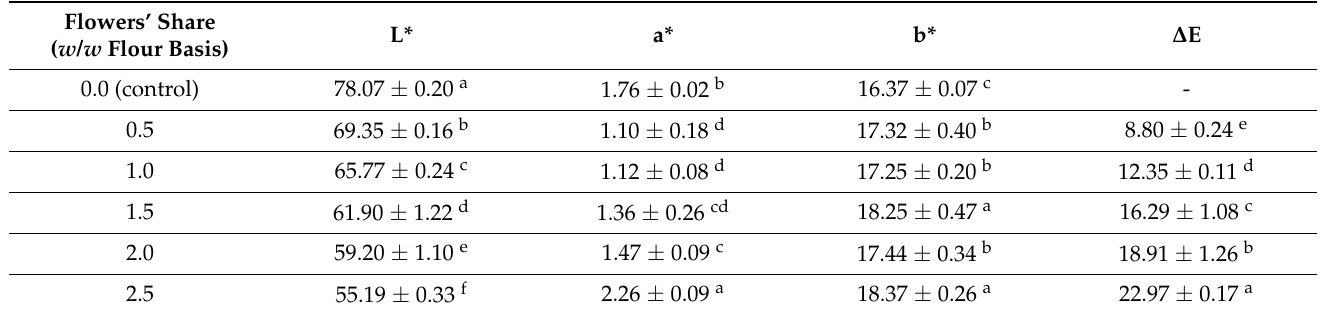
Table 3. Color of wheat dough enriched with J. regia male